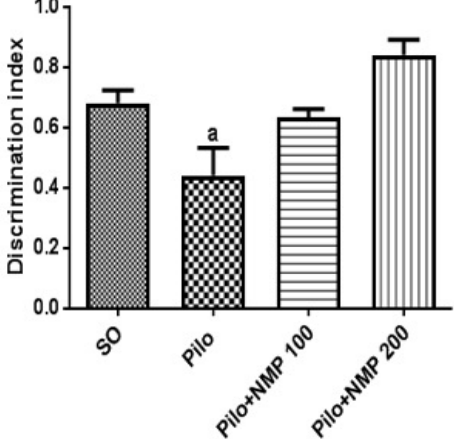
Figure 1. The N - methyl-(2S,4R)-trans-4-hydroxy- L -proline-rich fraction (NMP) prevented the behavioral changes in the recognition memory induced by the intracerebroventricular (icv) injection of pilocarpine (Pilo), evaluated by the novel object recognition test in mice. The animals received Pilo (300 µg/1 µL, icv) and, 24 h after, were treated for 15 days with NMP (100 or 200 mg/kg, per os , po ; Pilo